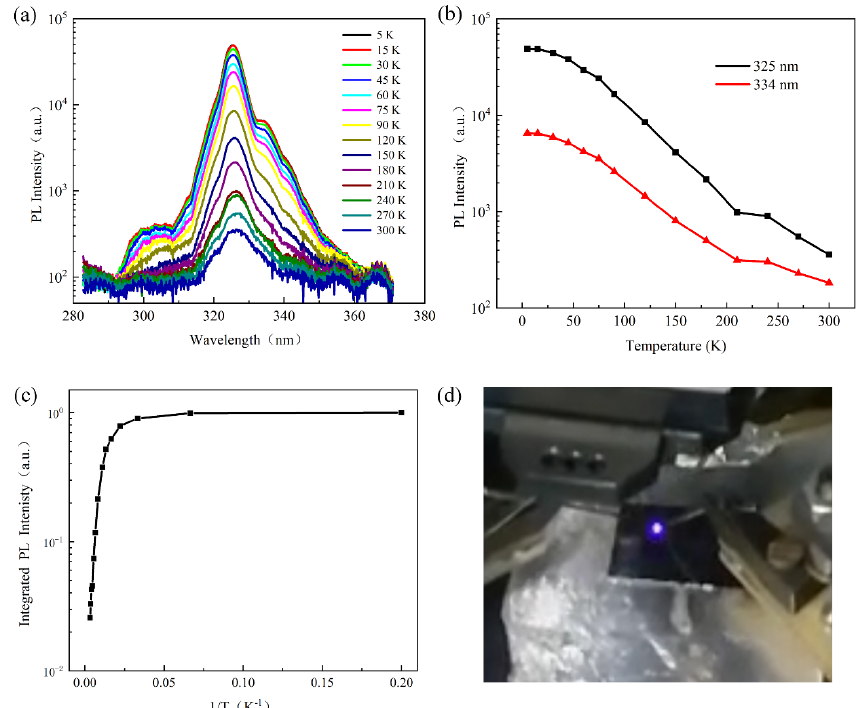
Figure 5. The photoluminescence properties and electroluminescence of AlGaN nanorod LEDs: ( a ) The spectra of temperature dependent PL; ( b ) the temperature dependence of PL intensity of peaks at 325 and 334 nm; ( c ) the temperature dependence of normalized integrated PL intensity of the AlGaN nanorod LEDs; and ( d ) optical image of the violet electroluminescence from the AlGaN nanorod LEDs.